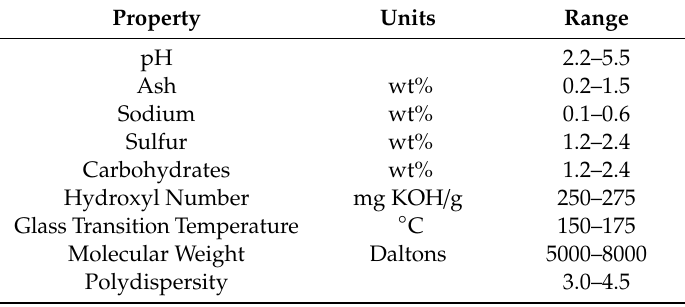
Table 2. Composition and properties of lignin used in this